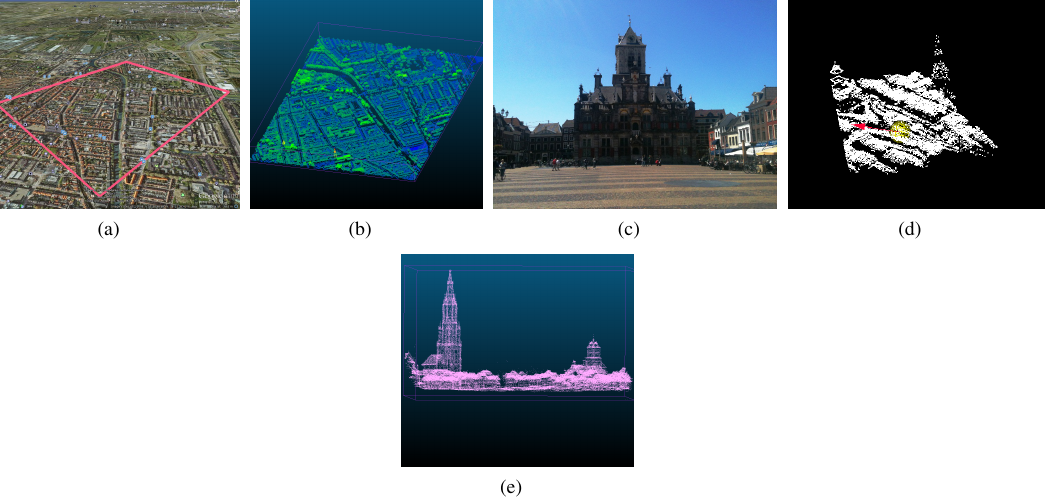
Figure 5: (a) AHN2 data acquisition area boundaries which is used in this study represented on Google Earth, (b) AHN2 point cloud height map is represented with color code, (c) iPhone photograph of the test building which is used at our demo application, (d) Geolocations of iPhone data acquisition position and the looking angle are represented on the AHN2 point cloud, (e) Sub-section of the AHN2 point cloud after selecting the interest study region considering the iPhone geolocations.